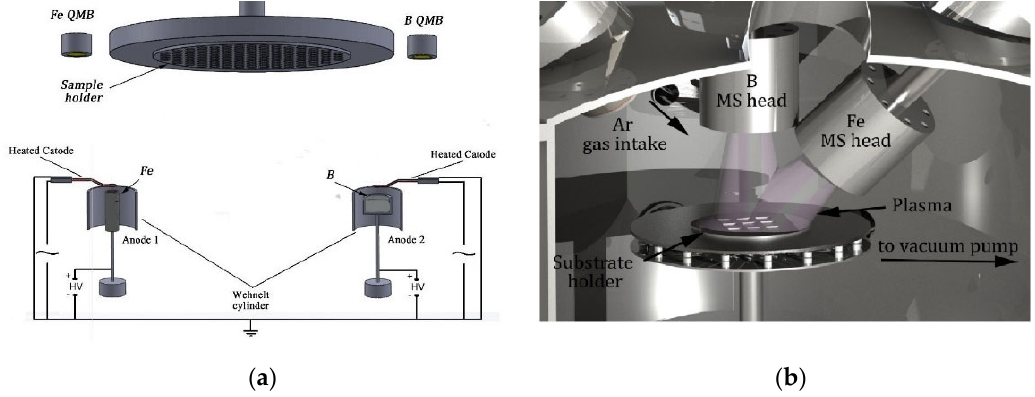
Figure 1. Experimental set-up for Fe-B deposits by ( a ) TVA method (left hand) and by ( b ) MS (right hand), respectively.